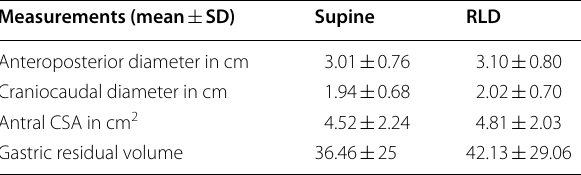
Table 3 Quantitative measurements in supine and RLD